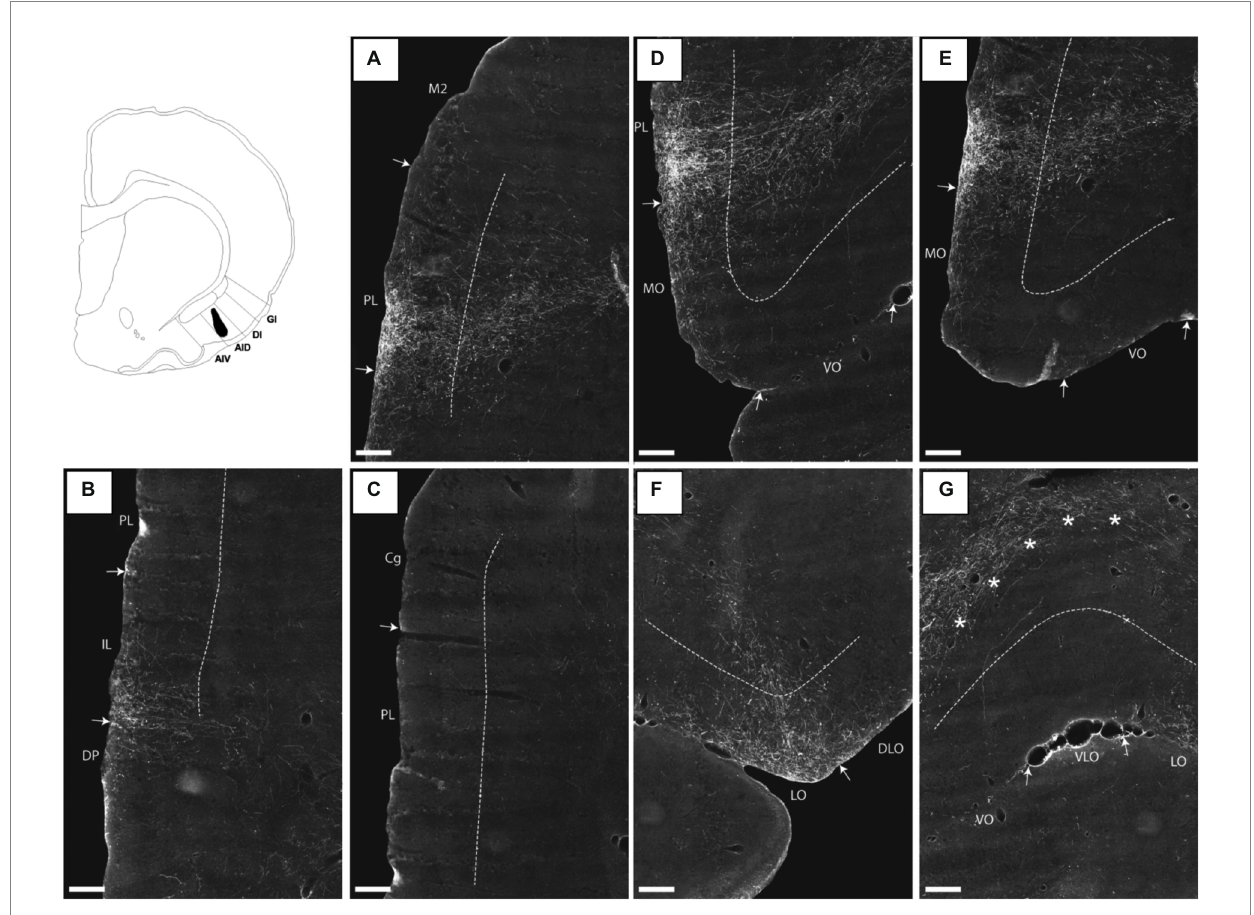
FIGURE 6 Images visualizing the fiber projections from a BDA injection covering all layers of the dorsal agranular insular field (AID) in the posterior insular domain (case 15307B). A schematic depicting the injection is shown in the upper left corner. (A) A dense fiber plexus is centered in the ventral portion of the prelimbic cortex (PL) at rostral levels. (B,C) At more caudal levels, the dense labeling targets specifically infralimbic cortex (IL) with sparser label in the dorsal peduncular cortex (DP). The image in (C) shows the same section as (B) at more dorsal levels, illustrating the diminishing of fiber labeling in prelimbic and anterior cingulate (Cg) cortices at this a-p level. (D,E) In medial portions of the orbitofrontal cortex, moderate fiber labeling is present in superficial layers of the medial orbital field (MO) but only very few labeled fibers are present in the ventral orbital field (VO). (F) A concentration of fiber labeling is present in superficial layers of the lateral orbital field (LO), with much sparser label in the dorsolateral orbital field (DLO). (G) Virtually no fibers are present in the ventrolateral orbital field (VLO). The dense-to-moderate labeled fiber path seen in the upper part of the image is positioned deep to layer 6 and does not target the orbitofrontal cortex. These fibers likely target the deep layers of mPFC as can also be seen in (D) . Dashed lines indicate the border between layers 3 and 5. The asterisks in G indicate the deep border of VLO and VO. AIV, ventral agranular insular field; DI, dysgranular insular field; GI, granular insular field. Scale bars equal 250 μ